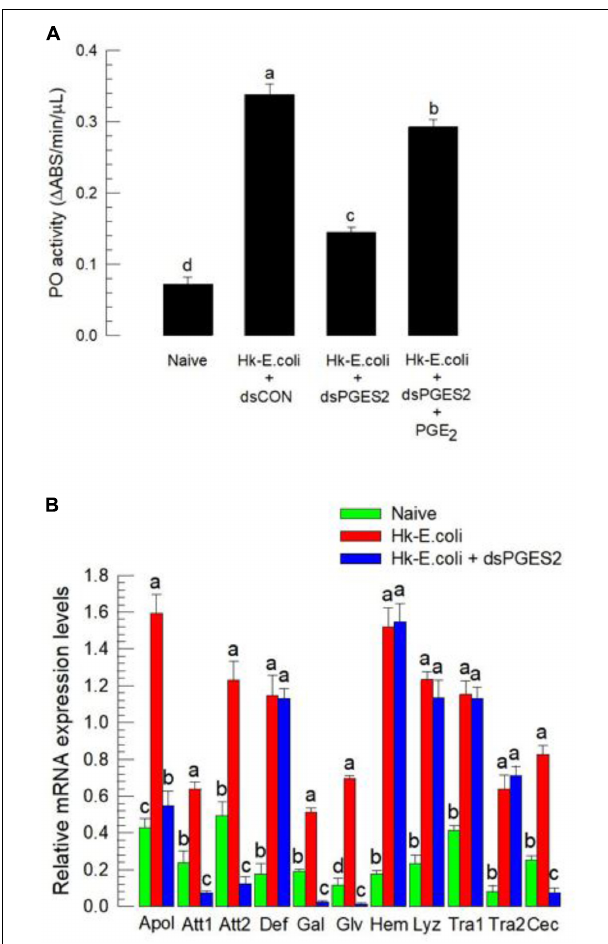
FIGURE 5 | The influence of dsSe-mPGES2 treatments on humoral immunity. dsRNA injected as described in Figure 3 . For a bacterial challenge, heat-killed (HK) E. coli (5.4 × 10 4 cells per larva) was injected into larvae at 48 h after dsRNA treatment. (A) Inhibitory effect of dsSe-mPGES2 on phenoloxidase (PO) activity in response to bacterial challenge. At 8 h PI of the bacteria, PO activity was measured. PGE 2 (1 µ g per larva) was injected along with the bacteria. (B) Inhibitory effect of Se-mPGES2 RNAi against the expression of 11 antimicrobial peptide (AMP) genes: apolipophorin III (“Apol”), attacin 1 (“Att1”), attacin 2 (“Att2”), defensin (“Def”), gallerimycin (“Gal”), gloverin (“Glv”), hemolin (“Hem”), lysozyme (“Lyz”), transferrin 1 (“Tra1”), transferrin 2 (“Tra2”), and cecropin (“Cec”). RL32 was used as an internal control. Each treatment was replicated three times. Different letters indicate significant differences among means at Type I error = 0.05 (LSD test).